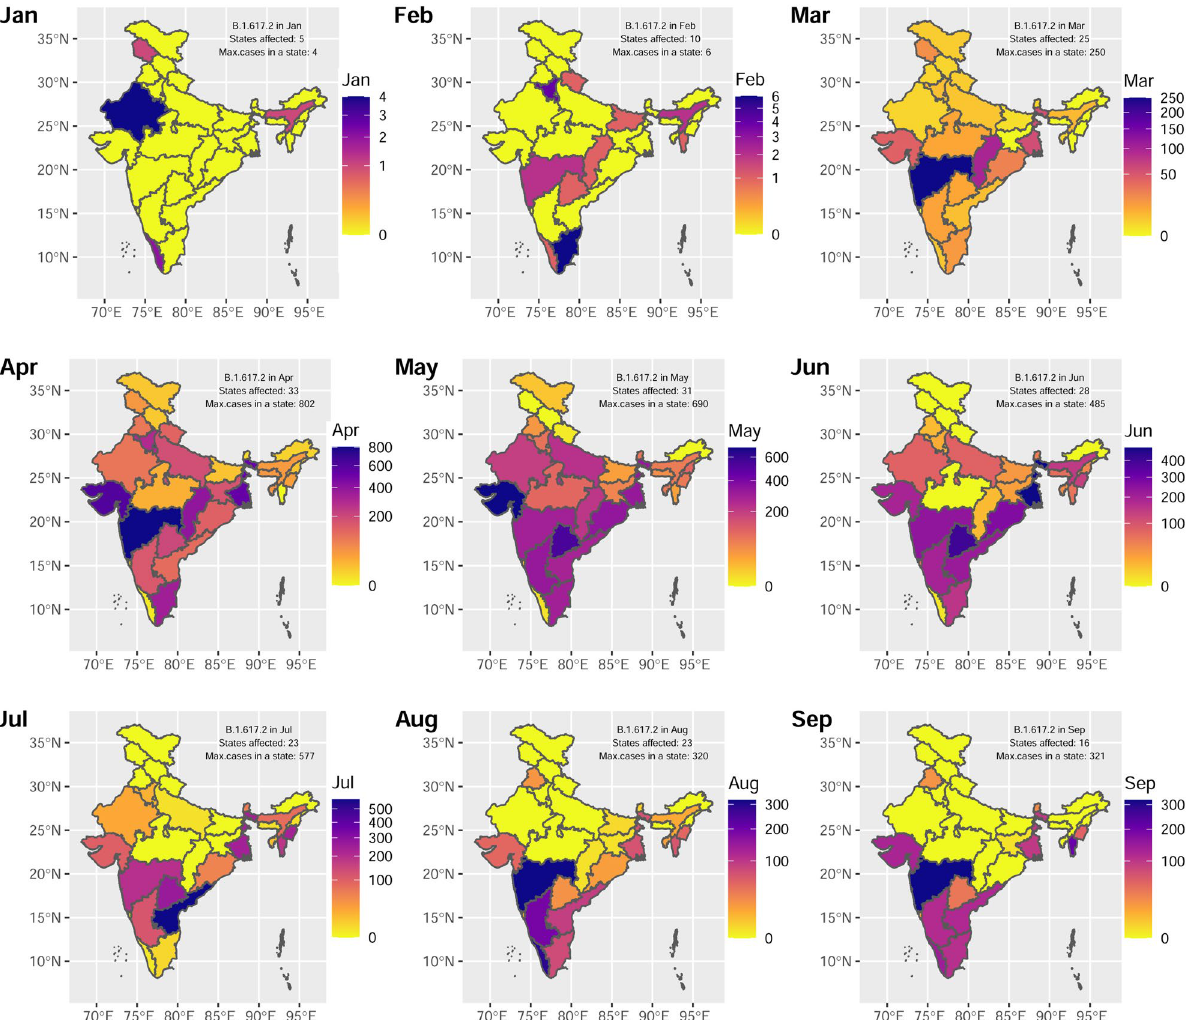
Figure 3. Spatiotemporal transmission/incidences of B.1617.2 (Delta) in Indian states and union territories (UTs). The dynamic incidences of Delta-surge in Indian states and UTs were shown in indicated months ( A–I ). The gradient scale showed the number of events/incidences of Delta for different states and UTs. The geographical/administrative boundaries are used only for the purpose of data representation. The spatial polygonal coordinates or boundaries of the states and UTs of India are obtained from the link url: https:// gadm. org/ downl oad_ count ry. html selecting the country India and the shape file: R (sf),